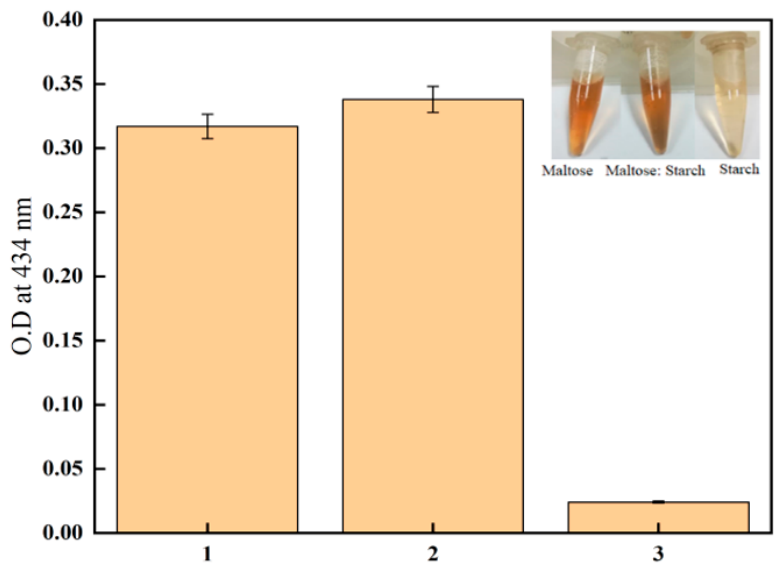
Figure 6. Selectivity for gelatin-silver reagent (1) maltose; (2) maltose: starch; (3) starch. Conditions: A 1 mL of the reaction mixture in sample 1 contained 185 µL of maltose (0.1 mM),190 µL distilled water, 125 µL of Tris-HNO 3 (0.2 M, PH 8.5); sample 2 contained 185 µL of maltose (0.1 mM), 185 µL of starch (1%), 125 µL of Tris-HNO 3 (0.2 M, PH 8.5); sample 3 contained 185 µL of starch (1%), 190 µL distilled water, 125 µL Tris-HNO 3 (0.2 M, PH 8.5); all samples incubated for 10 min at 90 °C, cooling read absorbance at 434 nm. Each point represents the mean of three experiments ± SE.